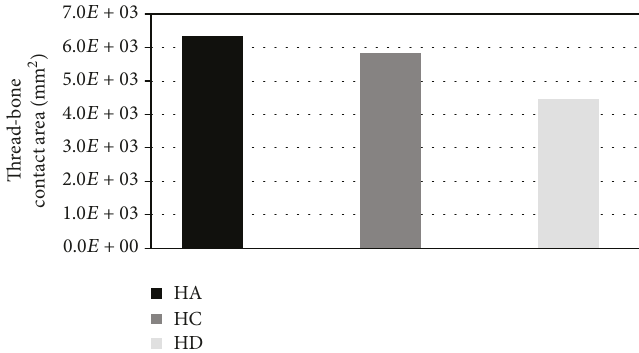
Figure 3: Di ff erences in thread-bone contact area using standardised